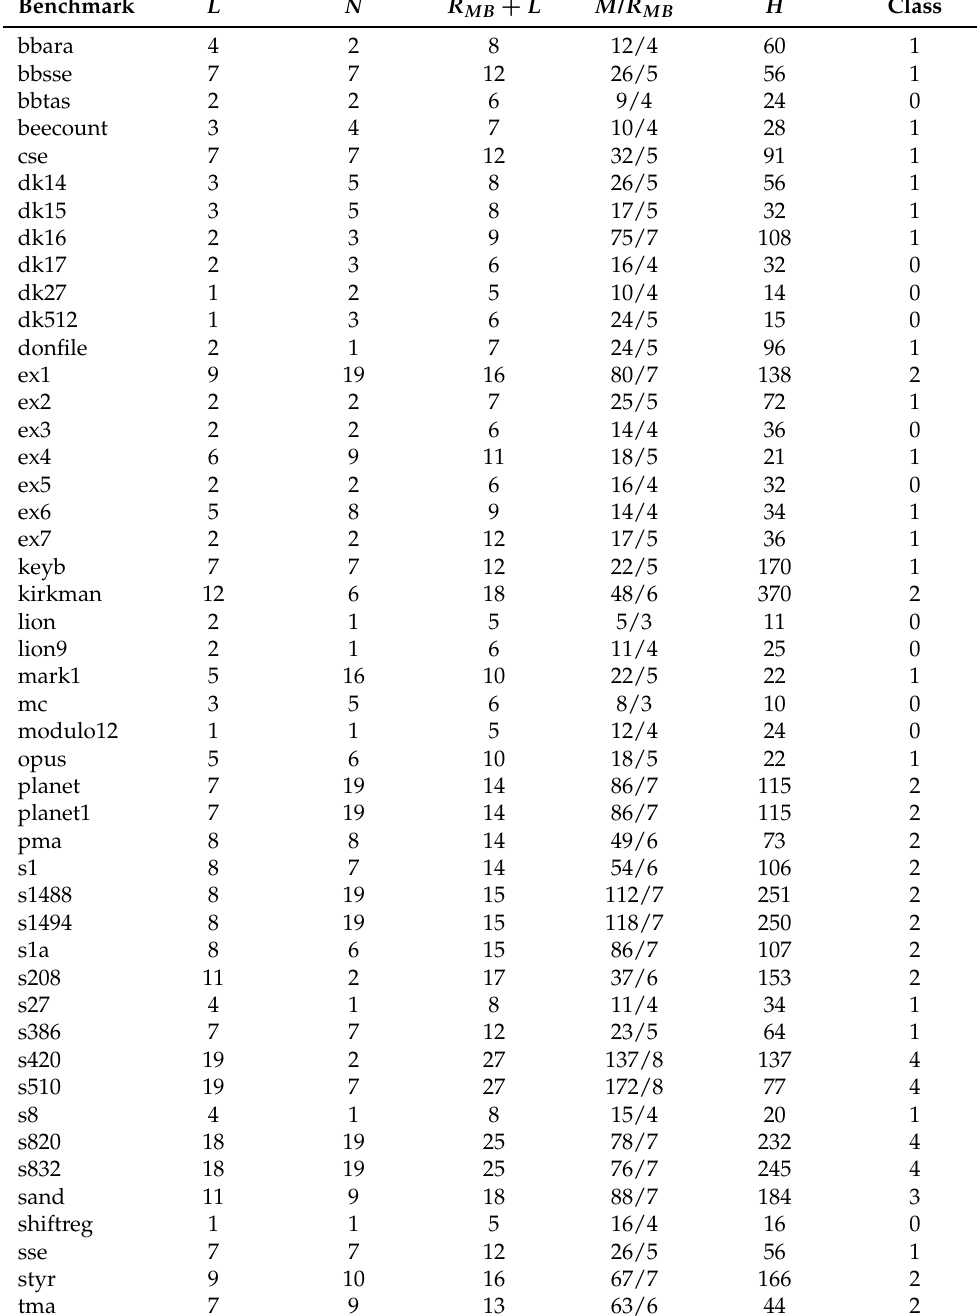
Table 8. Characteristics of benchmarks